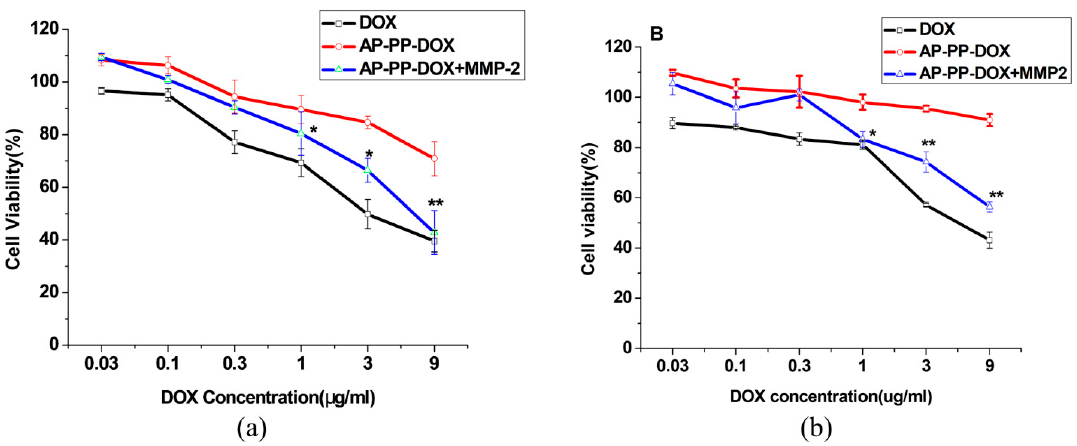
Figure 7. Cytotoxicity of AP-PP-DOX nanoparticles in cancer cells. ( a ) A549 ( b ) MCF-7. The cell viability assay was performed after 48 h with/without MMP2. Data were expressed as the mean ± SD. ( n = 6, * p < 0.05, ** p < 0.01 vs. AP-PP-DOX).